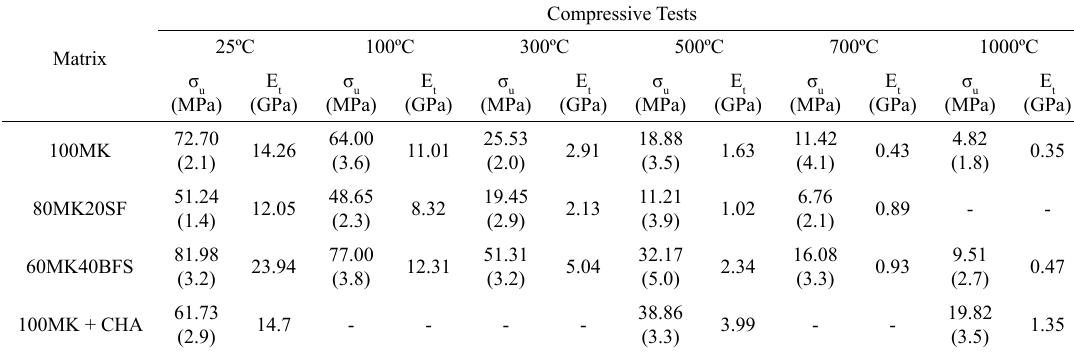
Table 5. Results of compressive tests performed in four different matrices submitted to temperatures up to 1000ºC (values in parentheses refer to standard deviation).